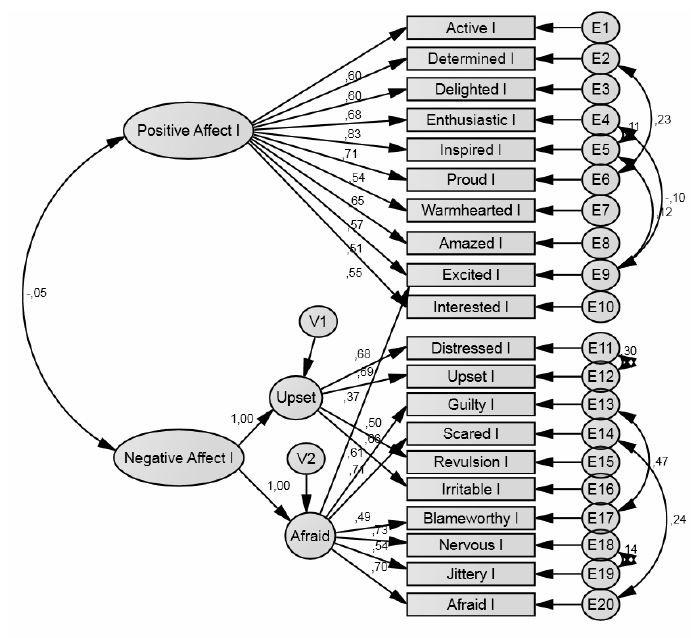
Figure 2 . Factor Structure of the PANAS. Alternative Model 8 (A8).